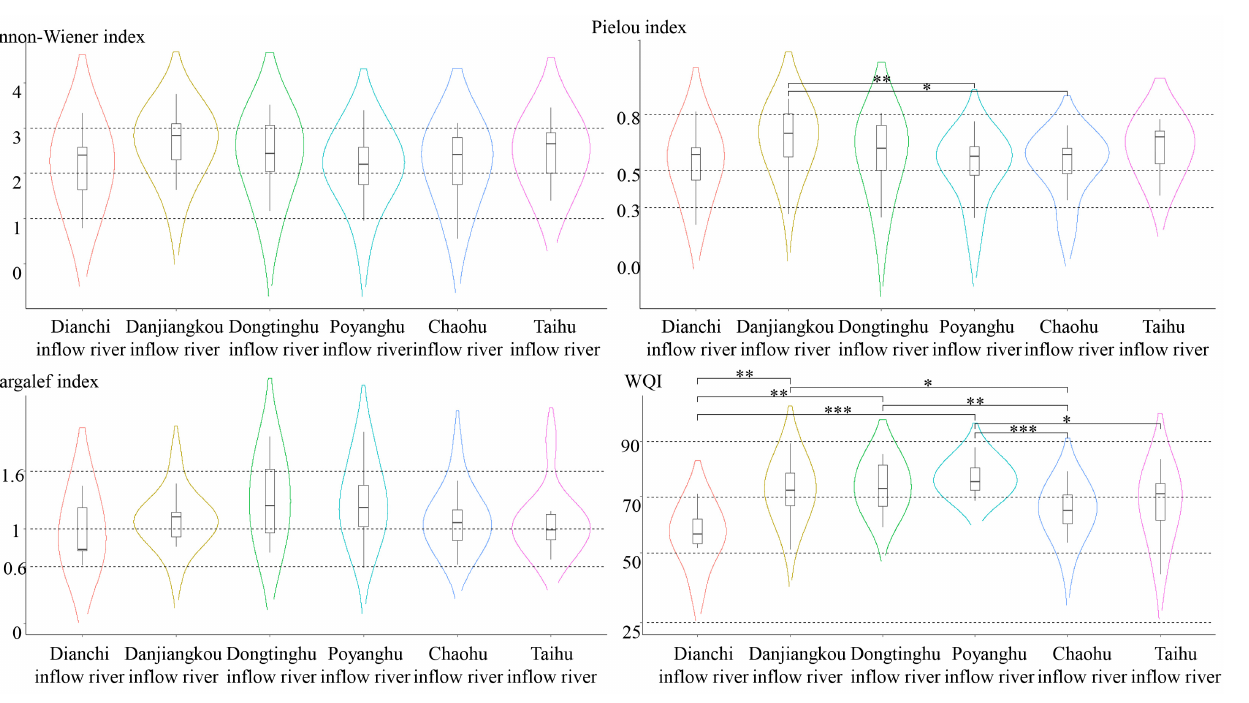
Figure 7. The Shannon–Wiener index, Pielou index, Margalef index and WQI of each inflow river. The dotted line indicates the assessment standard of each index. Wilcoxon rank sum test was used to compare different groups; *** indicates p < 0.001, ** indicates p < 0.01, * indicates p <